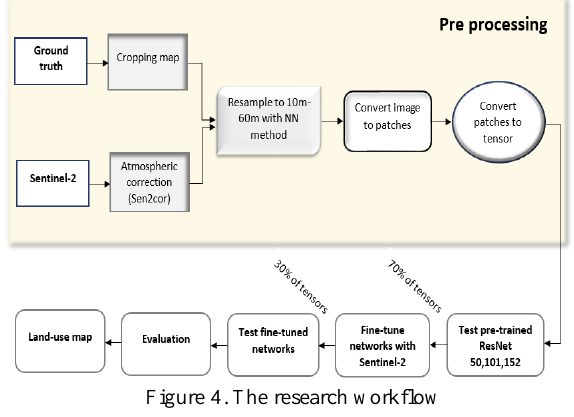
Figure 4. The research